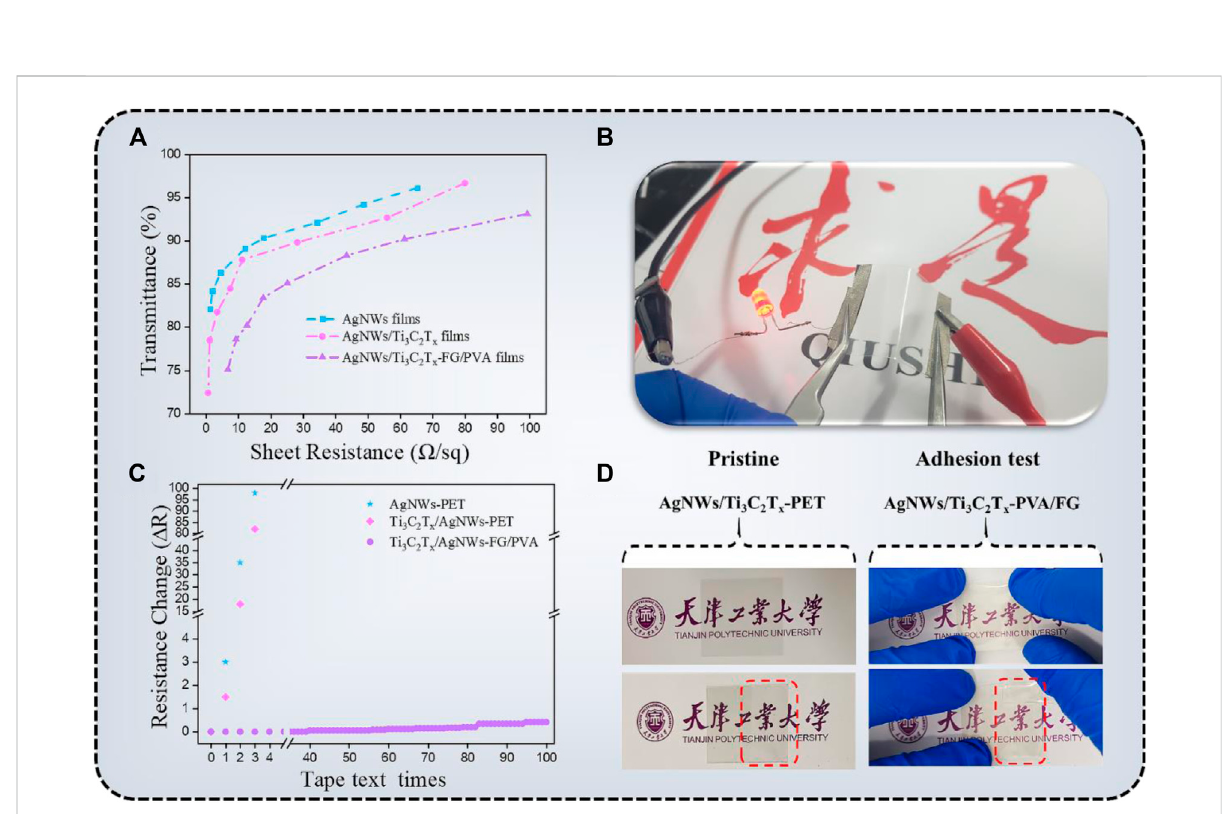
FIGURE 6 (A) Therelationshipbetweenthetransmittance(at550 nm)andsheetresistanceofAgNWs-PET,AgNWs/Ti 3 C 2 T x -PET,AgNWs/Ti 3 C 2 T x -FG/PVA TCFs; (B) Photograph of the AgNWs/Ti 3 C 2 T x -FG/PVA TCF connects to a LED; (C) The sheet resistance change of AgNWs-PET, AgNWs/Ti 3 C 2 T x -PET, AgNWs/Ti 3 C 2 T x -FG/PVA fi lms as a function of tape test times; (D) Photograph of the AgNWs/Ti 3 C 2 T x -PET and AgNWs/Ti 3 C 2 T x -FG/PVA fi lms after tape